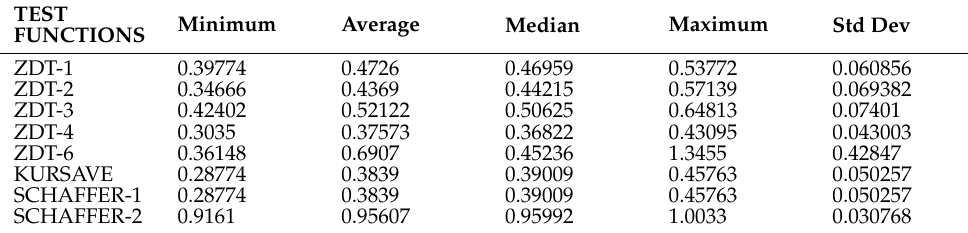
Table 6. Results of DIVERSITYMETRICS on test functions.